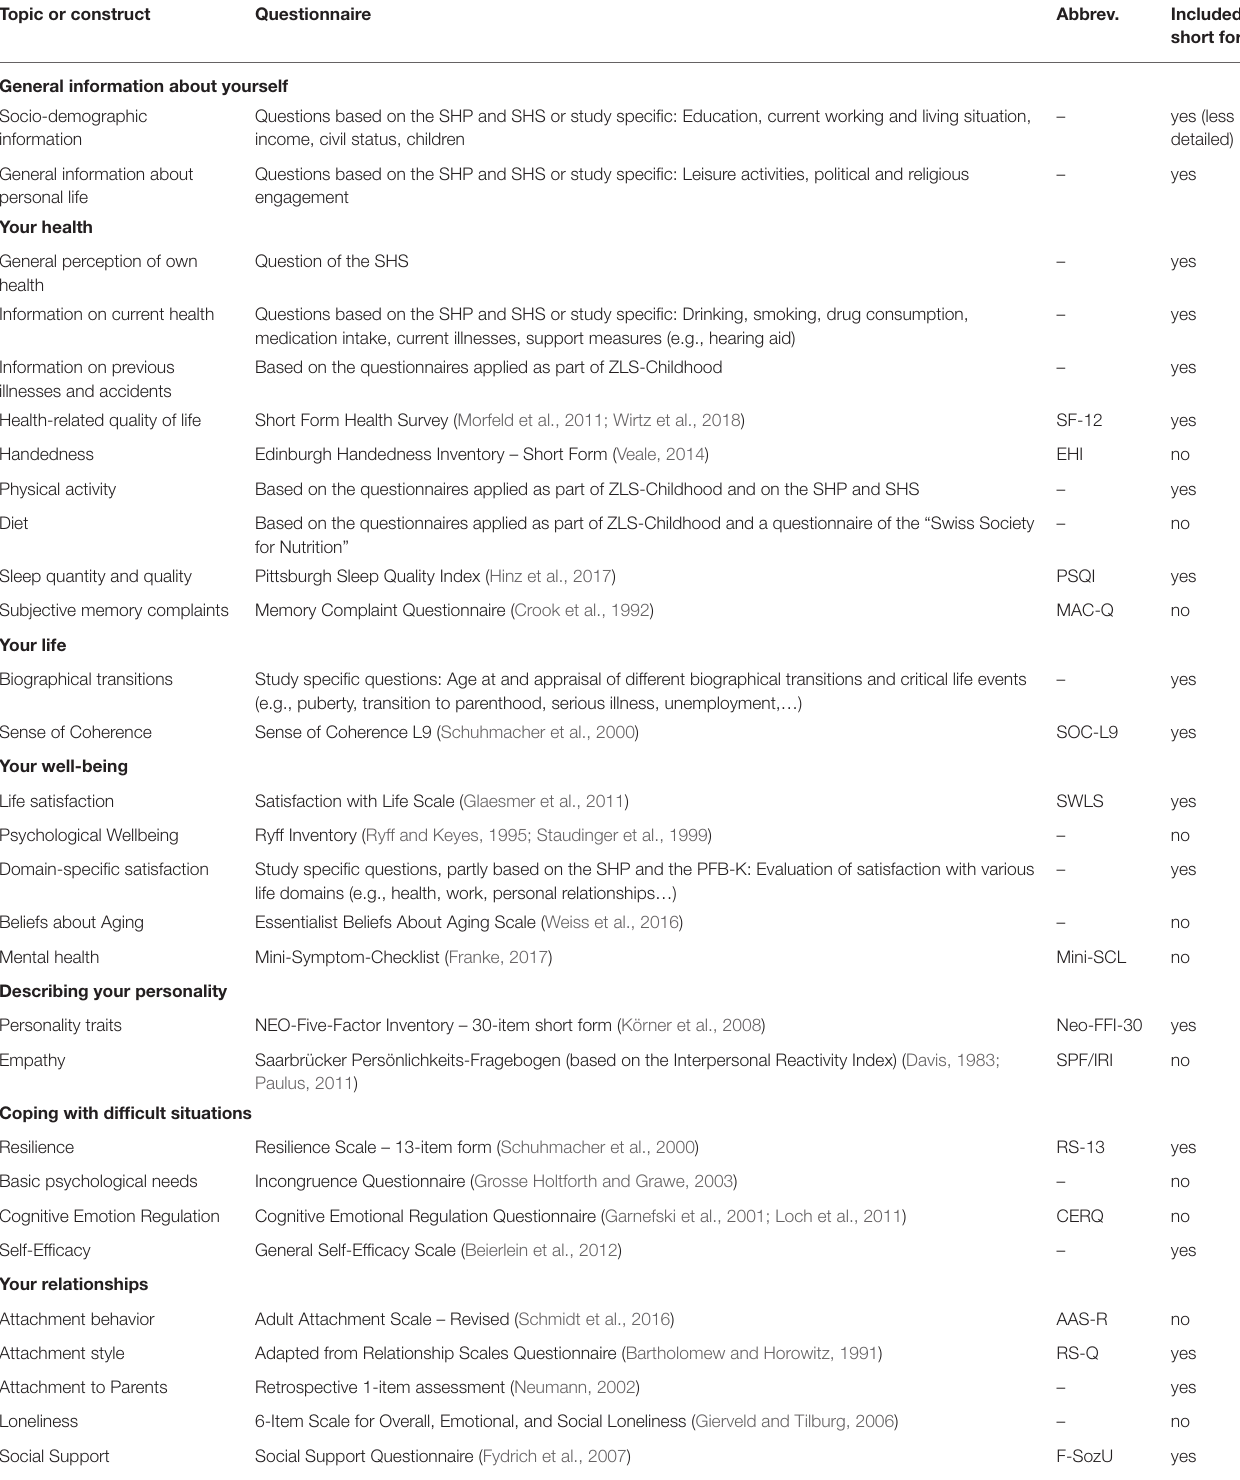
TABLE 3 | List of questionnaires completed by participants during the first wave of ZLS-Adulthood assessments. Topic or construct